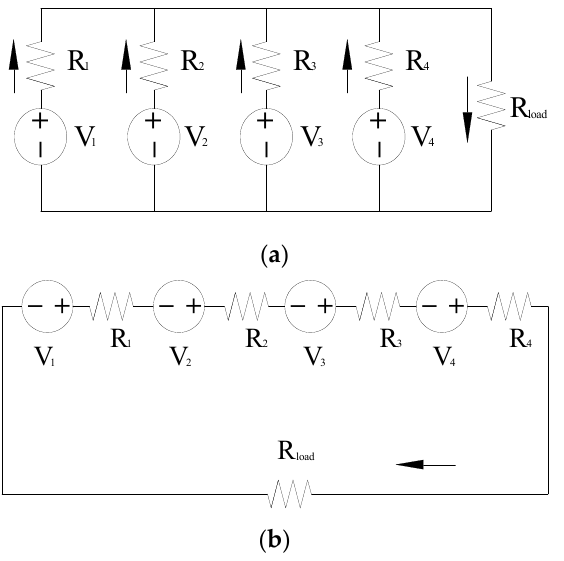
Figure 9. ( a ) parallel, ( b ) series. Electrical schematic of an array of four TEG modules electrically connected in parallel and series.